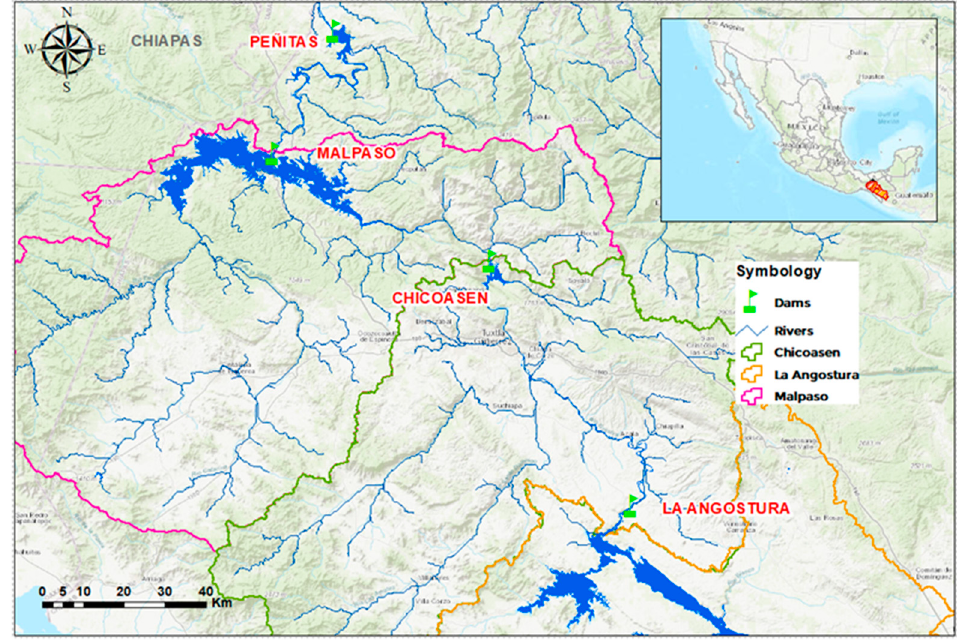
Figure 1. Location of dams in the Grijalva System. Source: Adapted with permission from [28]. La Angostura and Malpaso are the dams with the largest regulation capacity; they have a useful capacity of 13,169 and 9317 hm 3 compared to Chicoas é n and Peñitas,